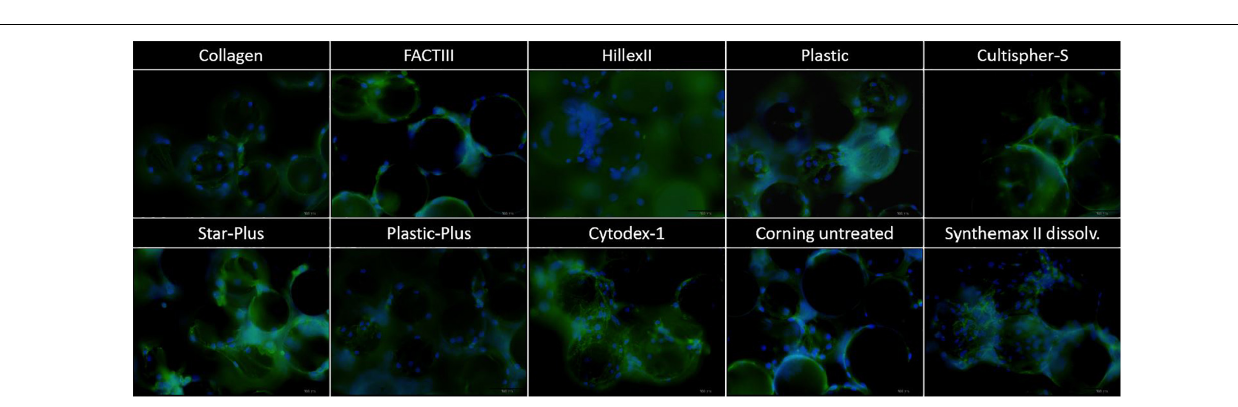
FIGURE 3 | DAPI imaging of the microcarriers Collagen, FACTIII, HillexII, Plastic, Cultispher-S, Star-Plus, Plastic-Plus, Cytodex-1, Corning untreated, and Synthemax II dissolvable. The nucleus is stained blue, the actine is stained green and each picture has a width of 550 µ